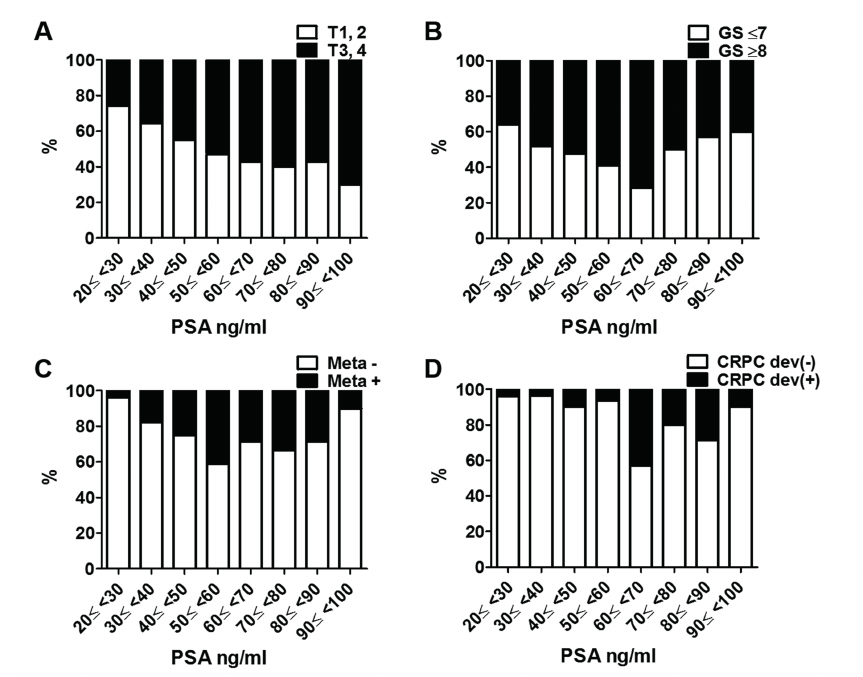
Figure 1 - The distribution of clinical factors in every 10 ng / mL across the range of PSA